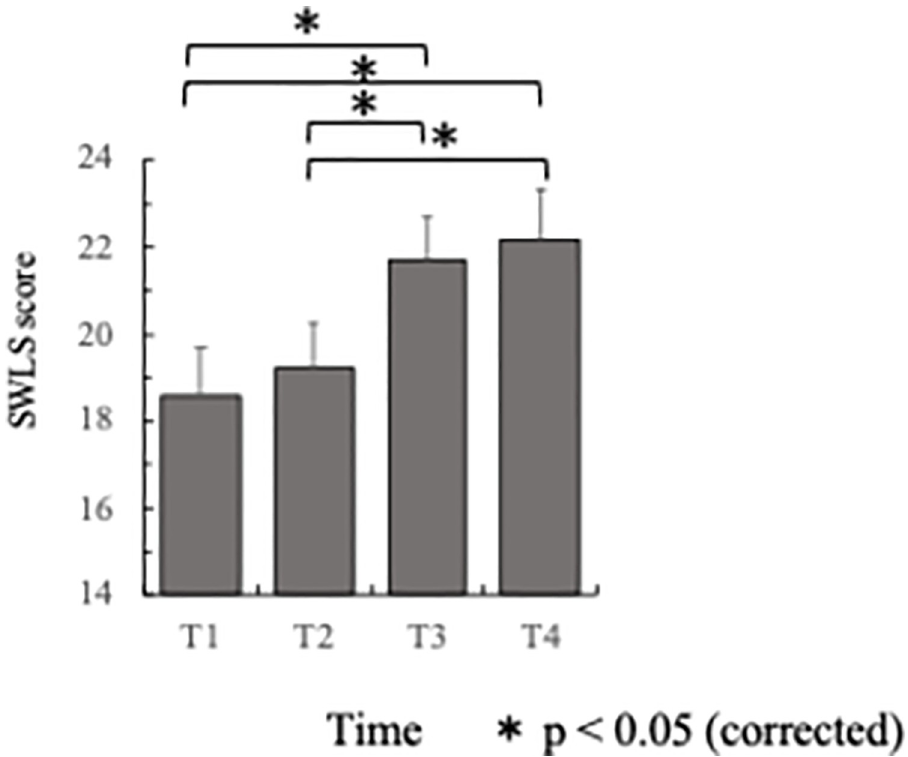
Fig 2. SWLS scores (averages) across time at T1, T2, T3 and T4 (see caption for Fig 1 for details). The asterisk ( � ) indicates statistically significant pairwise differences (p < 0.05 level), corrected for multiple comparisons using the Bonferroni method. Error bars indicate one standard